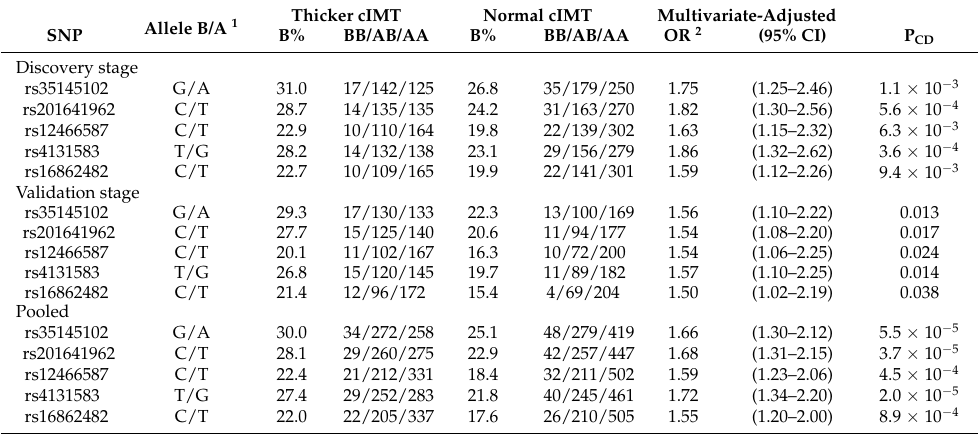
Table 1. Association analyses for five candidate SNPs with thicker carotid IMT.